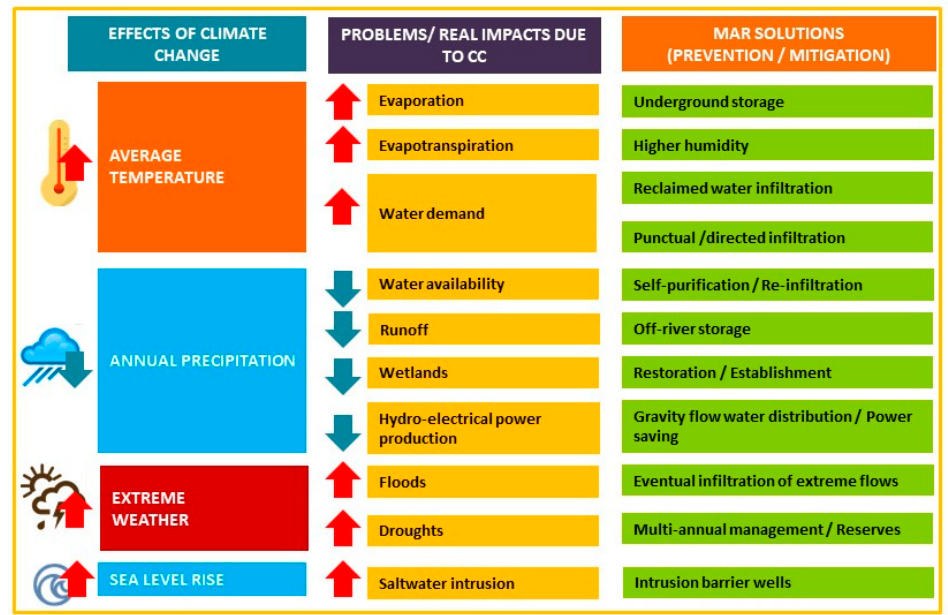
Figure 1. Relationships between the main manifestations of climate change (CC) and their main problems and impacts, and the technological solutions that can be implemented as adaptation measures.